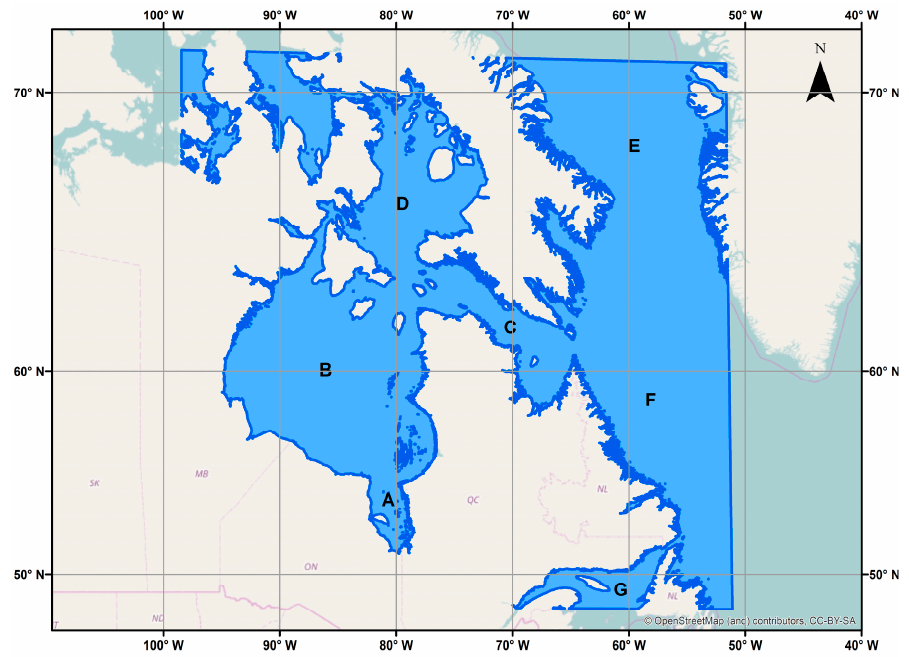
Figure 1. Test area for IceMap250, including James Bay ( A ), Hudson Bay ( B ), Hudson Strait ( C ), Foxe Basin ( D ), Davis Strait ( E ), Labrador coast ( F ), and part of the Gulf of Saint-Lawrence ( G ), all located in eastern Canada.